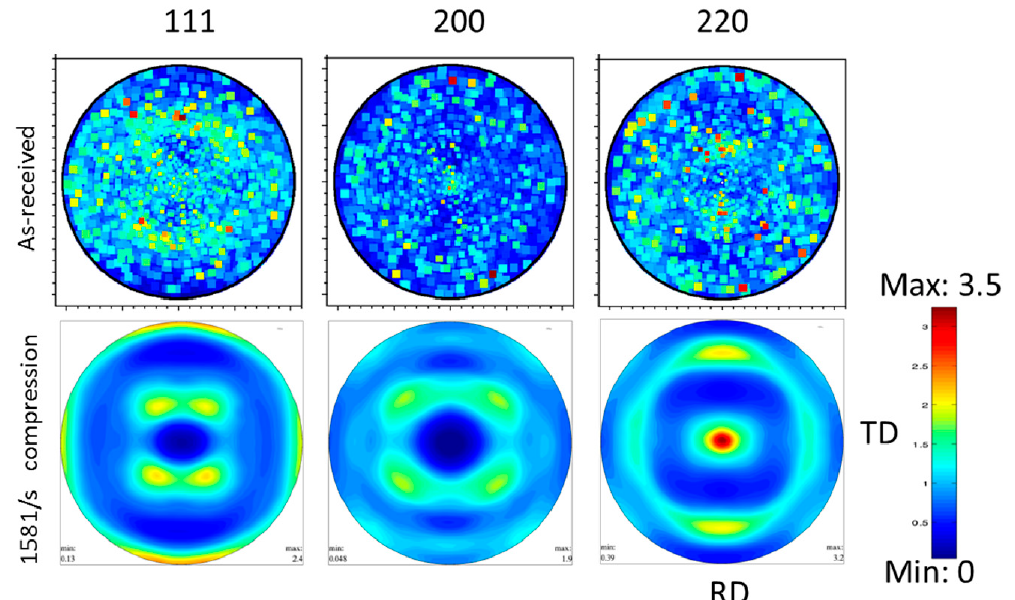
Figure 4. The (111), (200) and (220) pole figures of TWIP steel for the as-received specimen (top row) and the specimen compression tested to a plastic strain ~20% at a strain rate of 1581/s (bottom row).